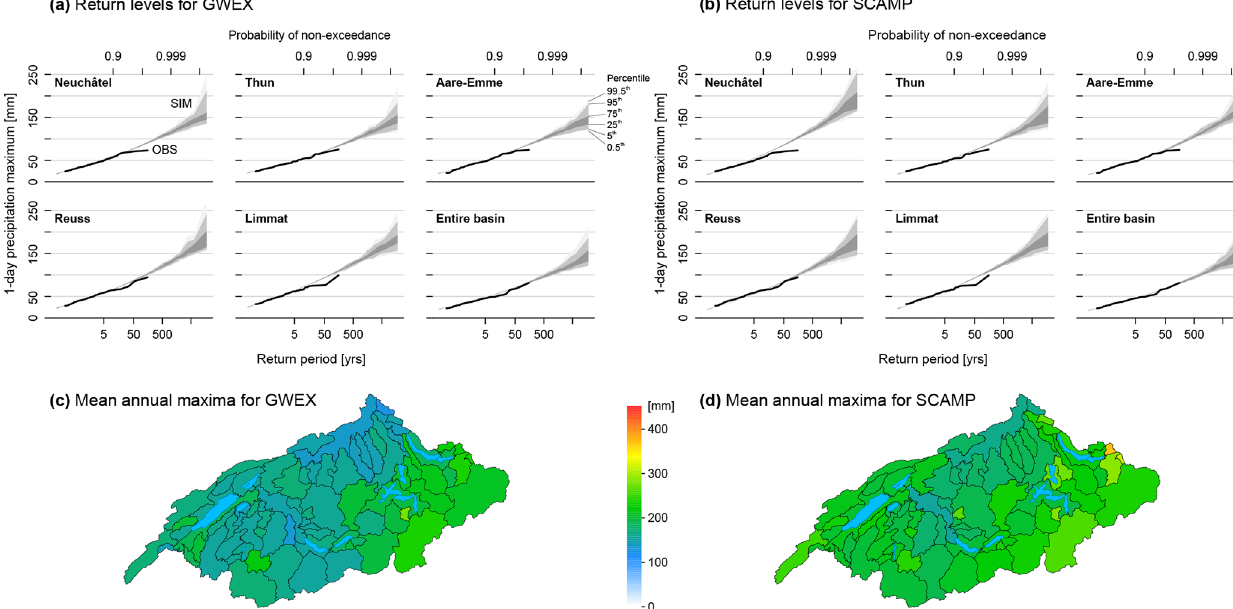
Figure 3. (a, b) Empirical return levels obtained for MAP1d (1d mean areal precipitation) from the 30 time series of 10000 years generated with GWEX (a) and SCAMP (b) for the entire Aare River basin and five main sub-regions using the Gringorten plotting position. The bounds of the grey-shaded areas correspond to the 0.5th/99.5th, 5th/95th and 25th/75th percentiles of the 30 time series, respectively. (c, d) Mean maximum simulated MAP1d from the 30 × 10000-year time series for each of the 80 HBV sub-catchments ( c : GWEX, d : SCAMP); major lakes are drawn in cyan. Note that the largest simulated MAP value in one 10000-year-long simulation corresponds to a return period of 18000 years (Gringorten plotting position). Also note that the extreme MAP values mapped do not necessarily occur simultaneously, i.e. do not correspond to one single